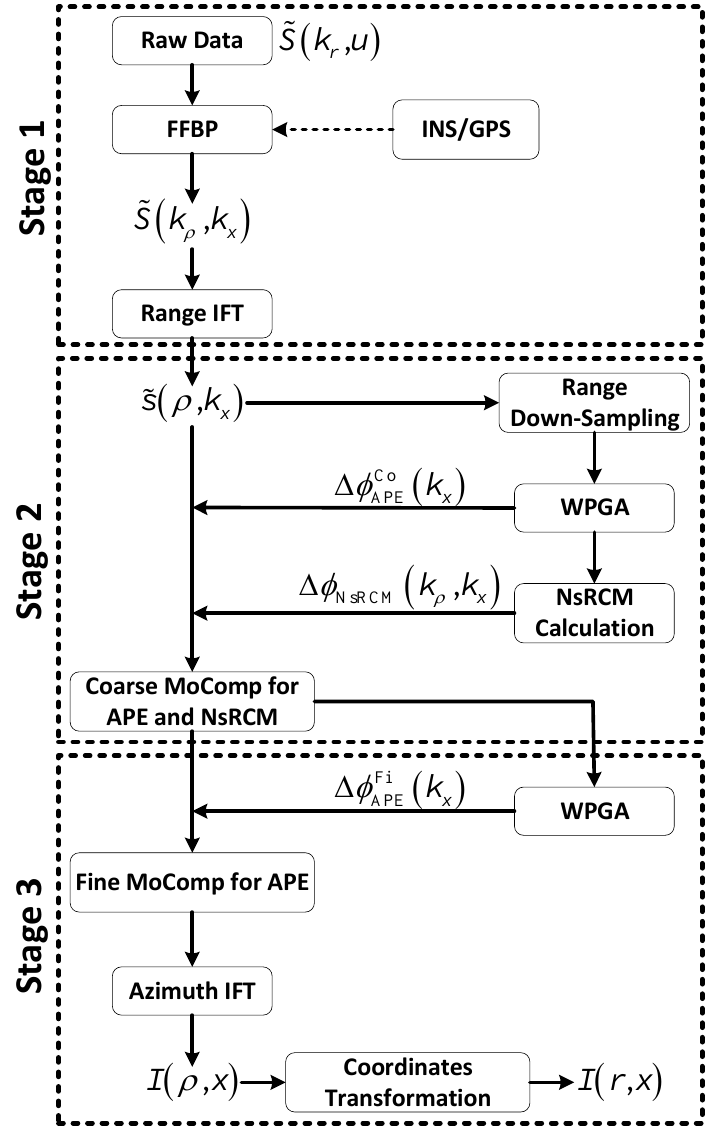
Figure 3. Processing flowchart of the proposed